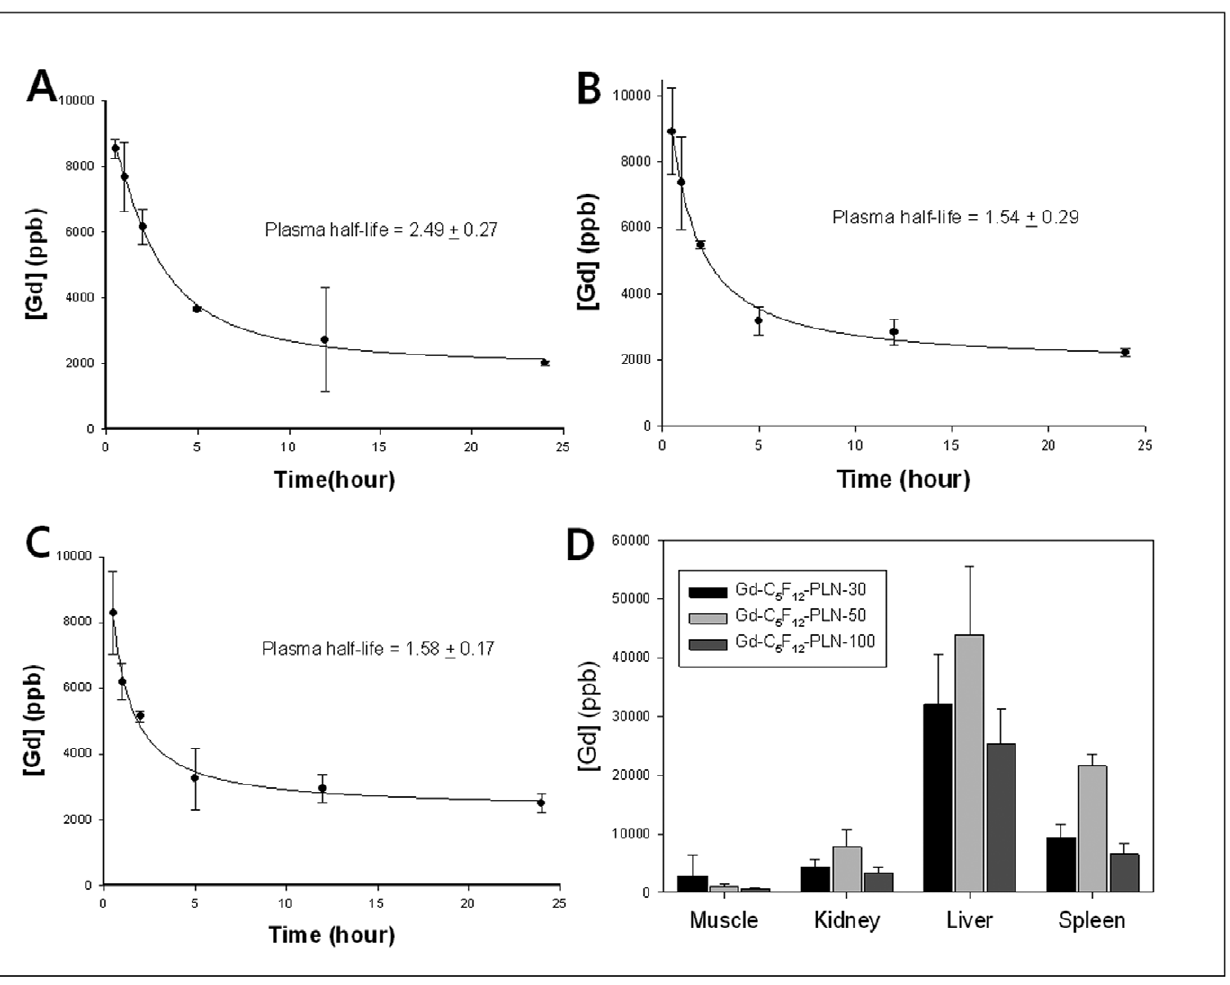
Figure 4. Circulation and distribution of Gd-C 5 F 12 -PLNs in mice. ICP-AES analysis of Gd in the blood after tail vein injection of the Gd-C 5 F 12 - PLNs showed that plasma half-life of Gd-C 5 F 12 -PLN-30 was 2.49 6 1.27 (A), Gd-C 5 F 12 -PLN-50 was 1.54 6 0.29 (B), and Gd-C 5 F 12 -PLN-100 was 1.58 6 0.17 (C). The body distribution of Gd-C 5 F 12 -PLNs was determined by [Gd] quantified by ICP-AES 24 hours after administering Gd-C 5 F 12 -PLNs in mice (D).